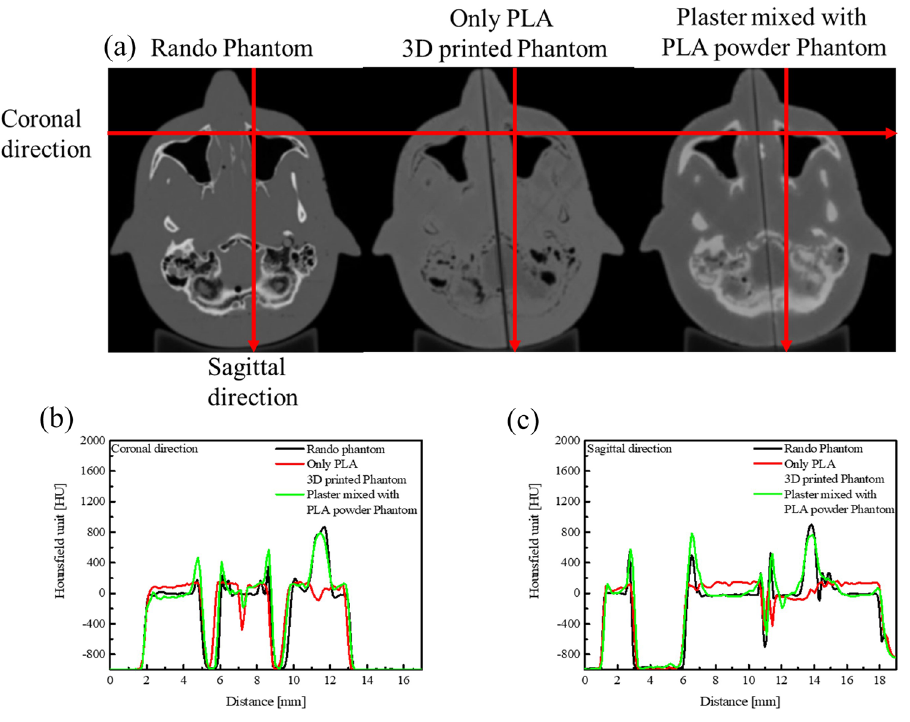
Figure 9. HU profiles along the red line in ( a ) the transversal plane CT images and in the ( b ) coronal and ( c ) sagittal